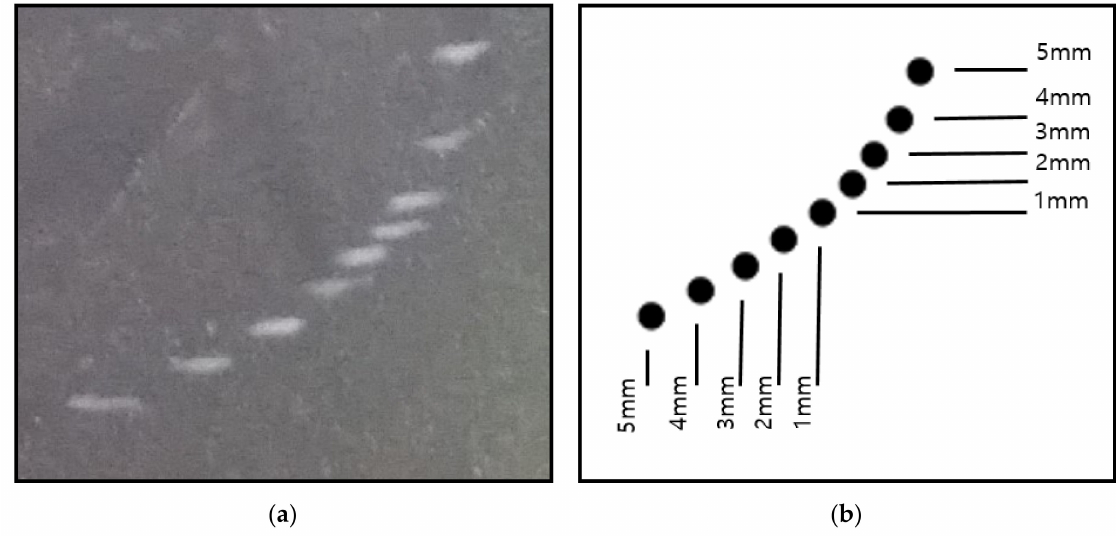
Figure 3. ( a ) Ultrasound resolution, ( b ) Resolution distance value.